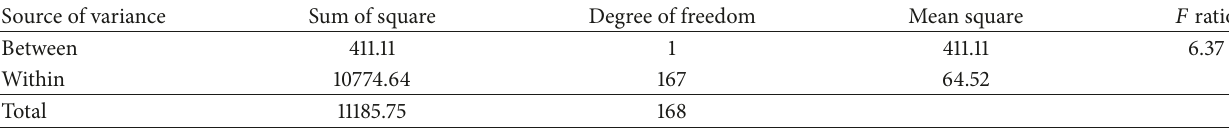
Table 5: ANOVA analysis for trader and nontrader.